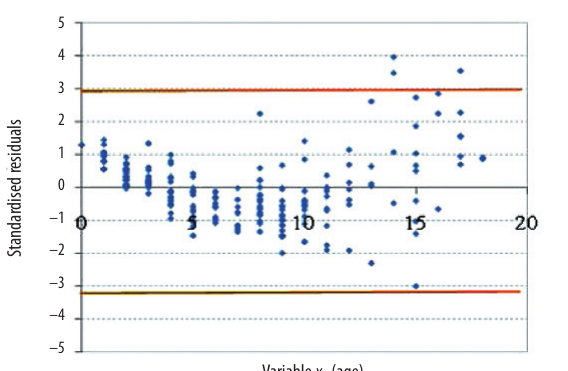
Fig. 4. Residuals versus dependent variable x